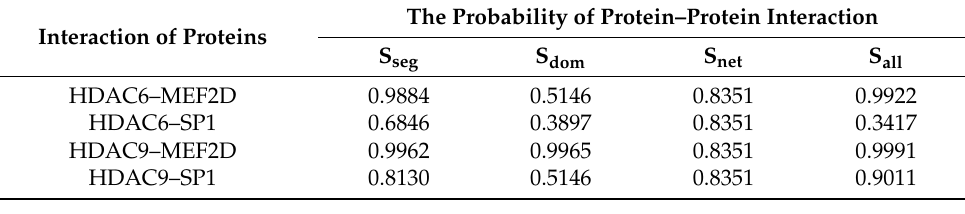
Table 2. The estimated probabilities that HDAC6 and HDAC9 can directly interact with MEF2D and SP1, as determined using a PPI prediction tool.